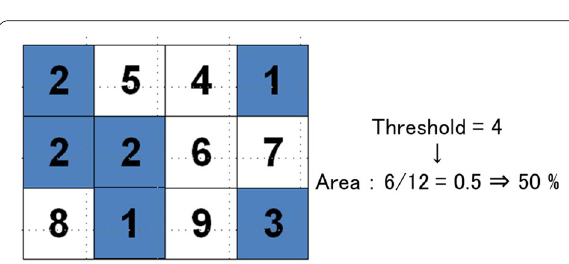
Fig. 3 Diagram of determining CH area. Pixels less than threshold are painted in blue